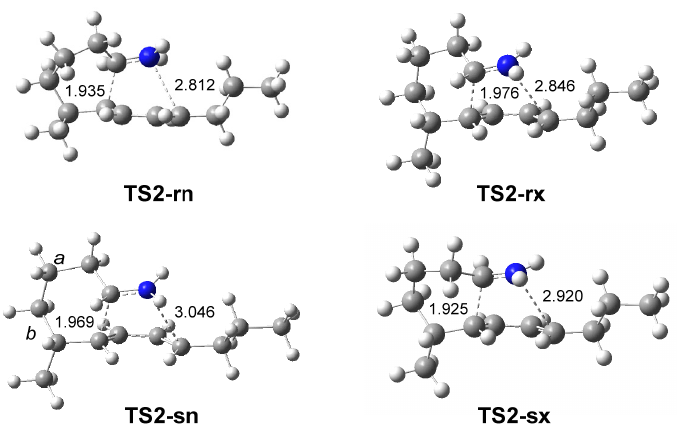
Figure 5. ω B97XD/6-311G(d,p) geometries of the TSs involved in the IIDA reaction of experimental dieniminium 12 . The C − C and C − N distances are given in Angstroms.